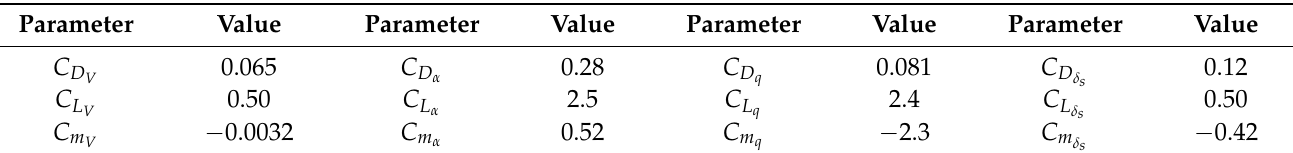
Table 4. The nondimensional stability and control derivatives of the X-59 longitudinal bare-airframe dynamics in flight condition 7220.